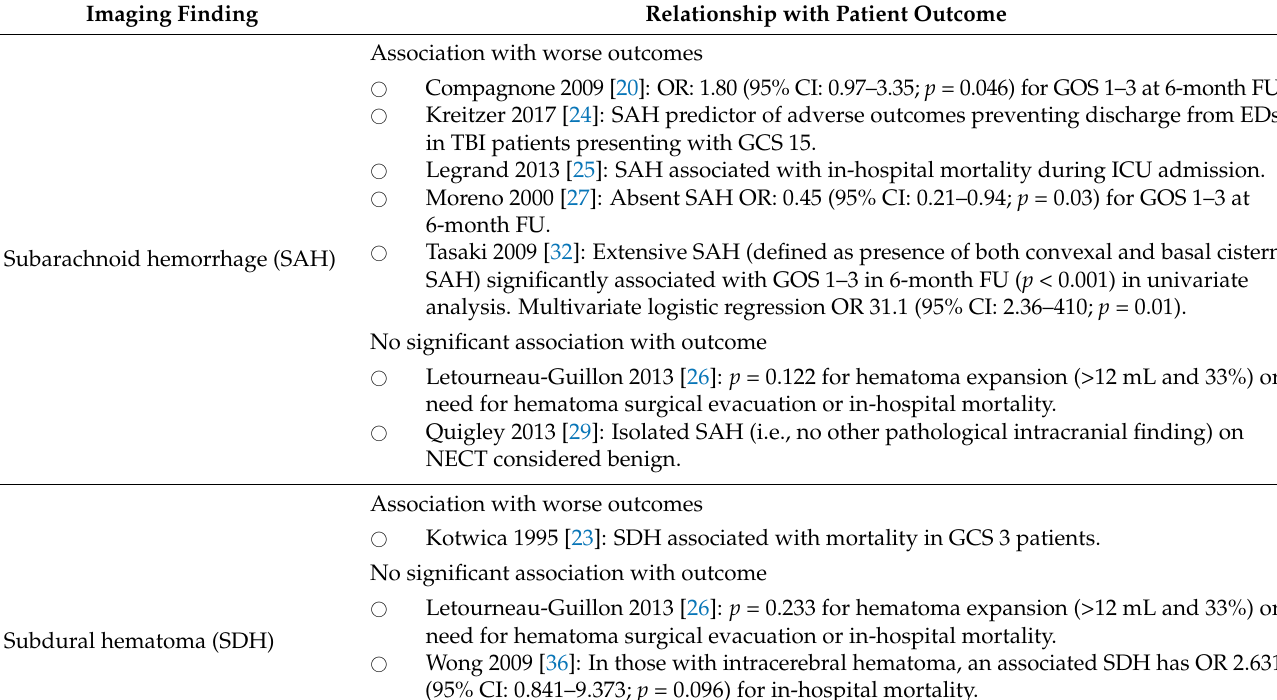
Table 2. Imaging findings and their association with patient outcomes. Imaging